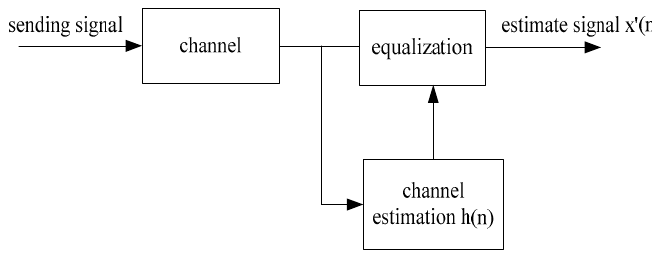
Figure 1. General procedure of channel estimation.